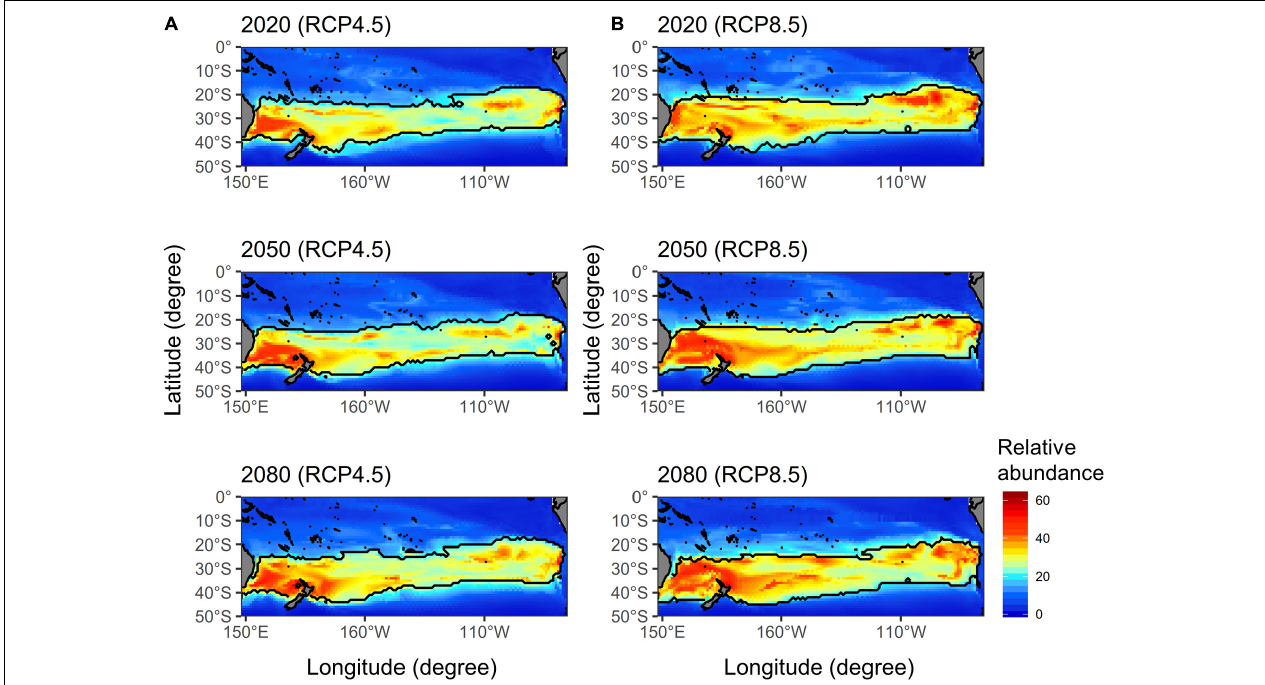
FIGURE 3 | The future ensemble projections of south Pacific albacore relative abundance (number/1,000 hooks) distributions in quarter 3 estimated from the five atmosphere-ocean general circulation models (AOGCMs) for the current (2020), mid (2050), and late (2080) periods of the twenty-first century under the (A) RCP 4.5 and (B) RCP 8.5 (right panel) scenarios. The solid black lines denote the preferred habitat boundaries defined by relative abundance > 25 number/1,000 hooks.